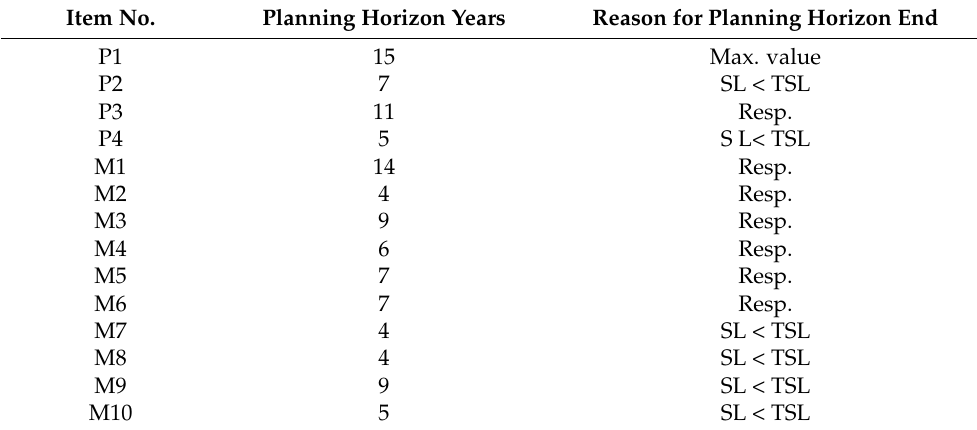
Table 5. Planning horizon for the researched spare parts. Item